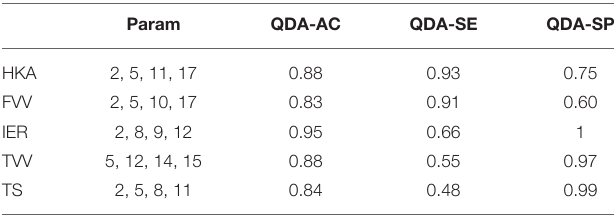
TABLE 5 | The four most representative SSM parameters for quadratic discriminant analysis.